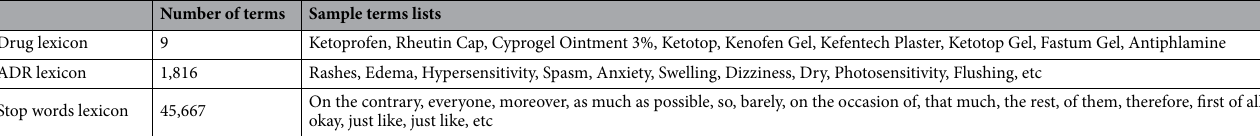
Table 1. Sample terms from each lexicon in